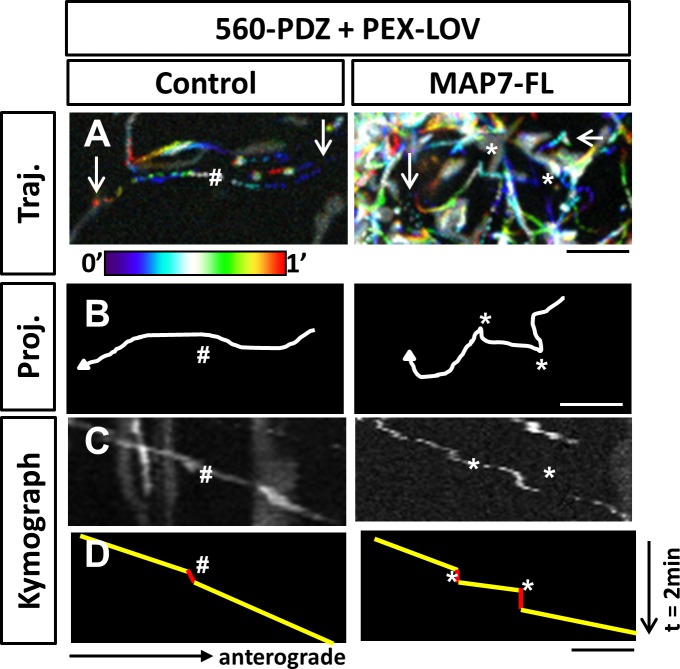
Optogenetic activation of kinesin-1-mediated peroxisome movement in COS cells.(A) Projections with temporal color-coding of sequential images at 1-s intervals show motile peroxisome trajectories in COS cells expressing PEX-LOV, 560-PDZ, and the iRFP control or MAP7-FL-iRFP. Arrows indicate the beginning and the end of each trajectory. The two ends of the color bar represent 0’ and 1’ respectively. (B) Line drawings of the trajectories in (A) show track switching behavior in MAP7 but not in control-expressing cells. (C, D) Kymographs (C) of PEX-LOV-labeled peroxisomes are generated based on the trajectories in (A, B). Each run track in the kymograph is represented by line drawing (D) to display regions of movement (yellow) and regions of pausing (red). Asterisks (*) indicate pause followed by sharp turns and pound signs (#) indicate pauses followed by smooth runs. Scale bars: 5 µm.